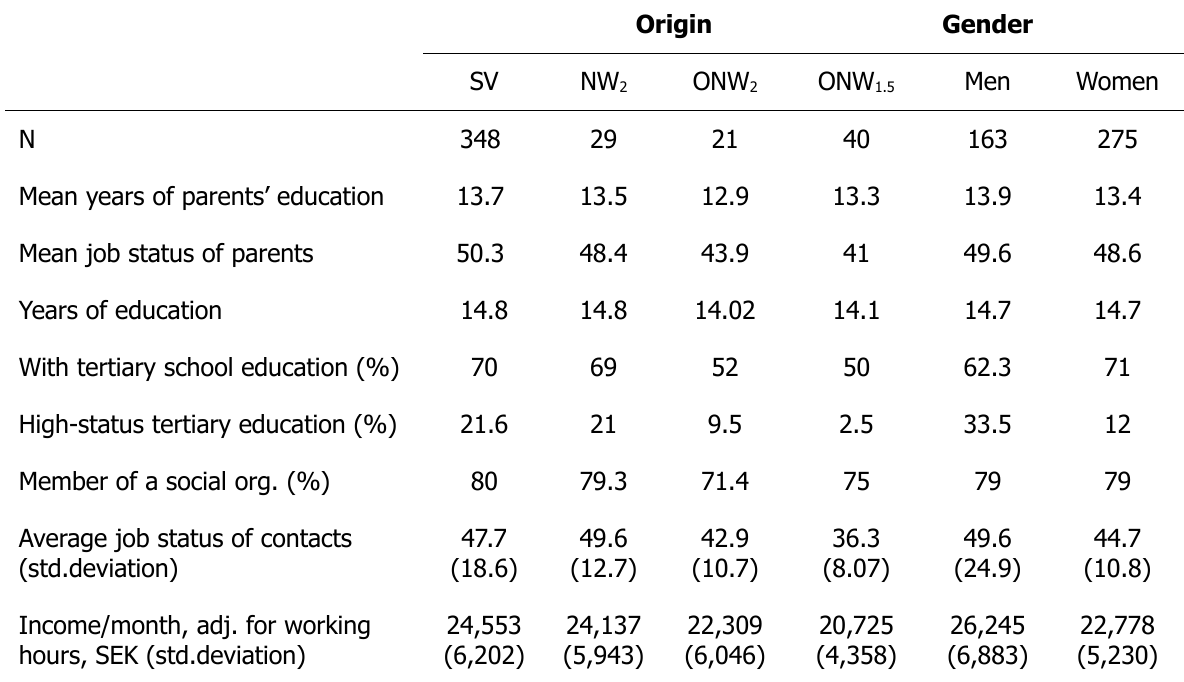
Table 2. Summary of sample characteristics on the subject of gender and origin, percent or means (standard